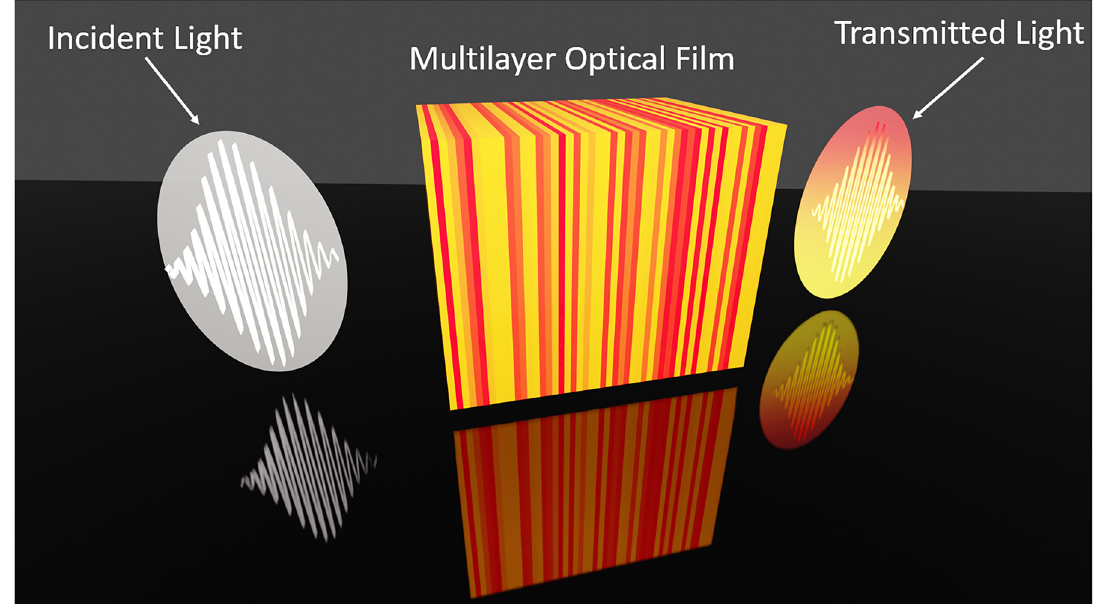
Figure 1: Transmission of unpolarized white light through an optical multilayer film stack. The different colors in the film stack represent the different refractive indices of the different